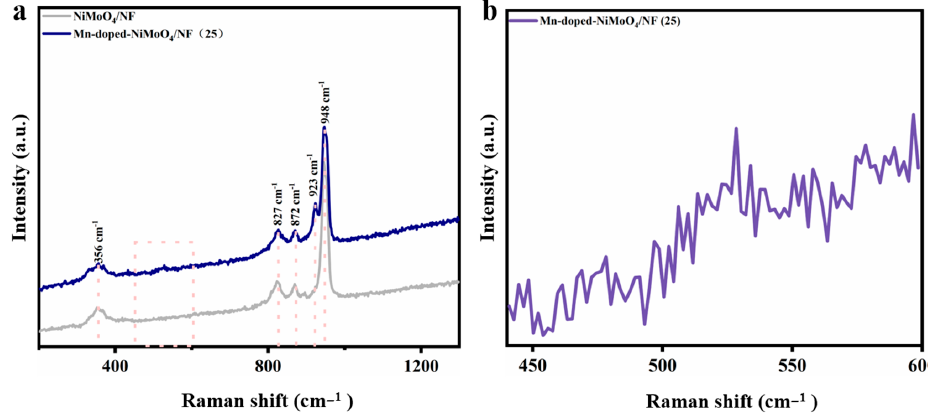
Figure 3. Raman spectra of ( a ) the Mn-doped-NiMoO 4 /NF (25) and NiMoO 4 /NF. ( b ) Enlarged view in the Raman shift range 440 cm − 1 –600 cm − 1 of the Mn-doped-NiMoO 4 /NF (25).